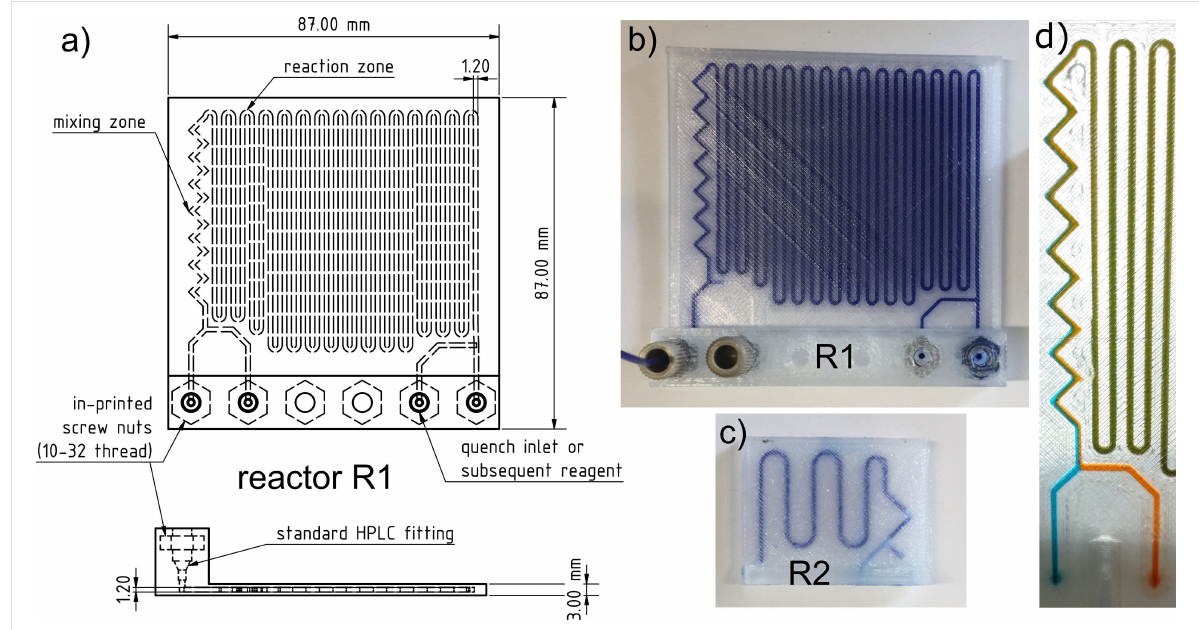
Figure 1: a) CAD drawing of the reactor R1. b) 3D-printed reactor R1 from the CAD drawing. The reactor is filled with a blue dye solution for better visibility of the channels. c) Early stage prototype of a 3D-printed flow reactor (R2). d) Mixing test of two dye